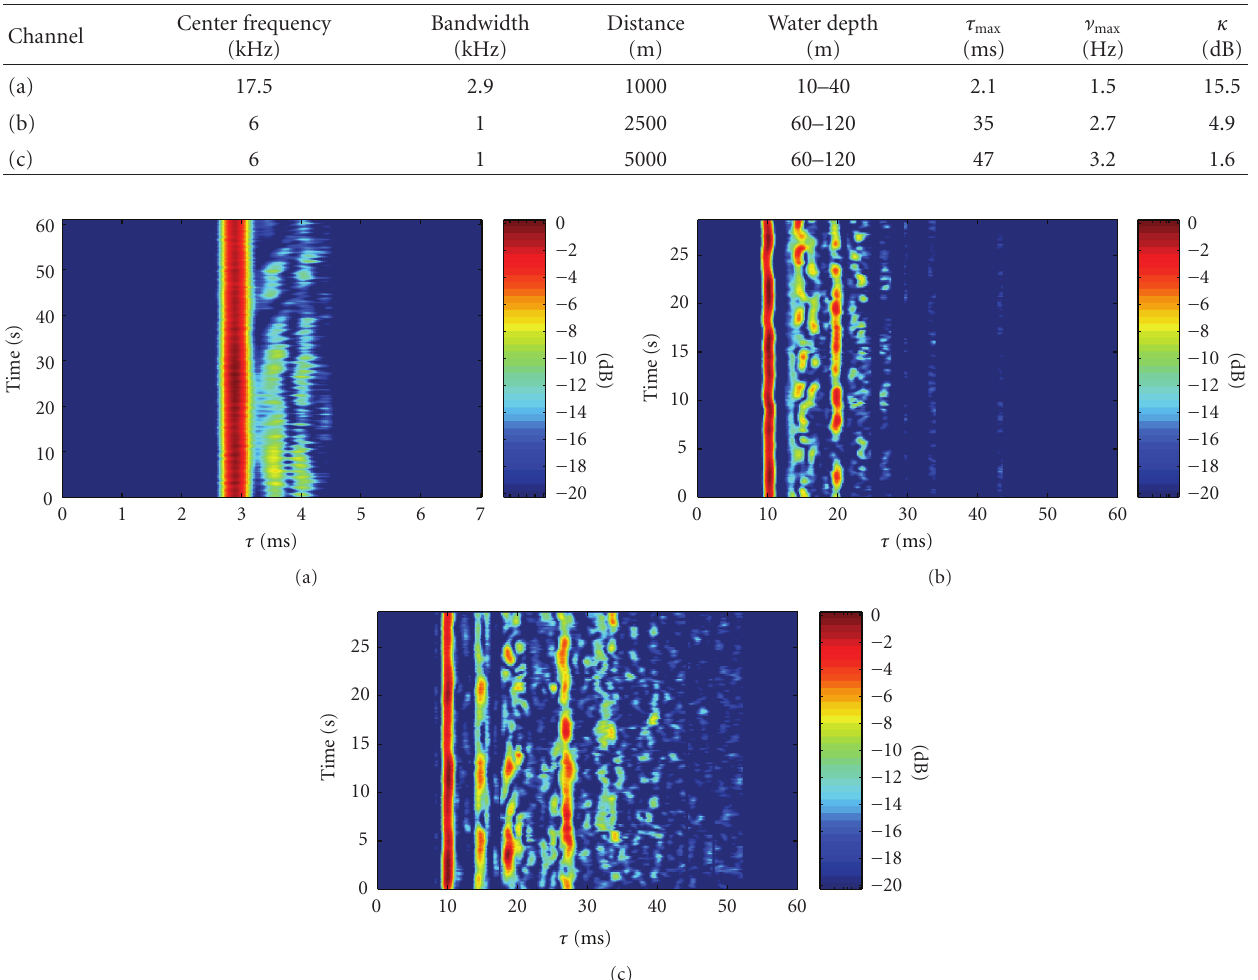
Table 1: Summary of at sea experiments.